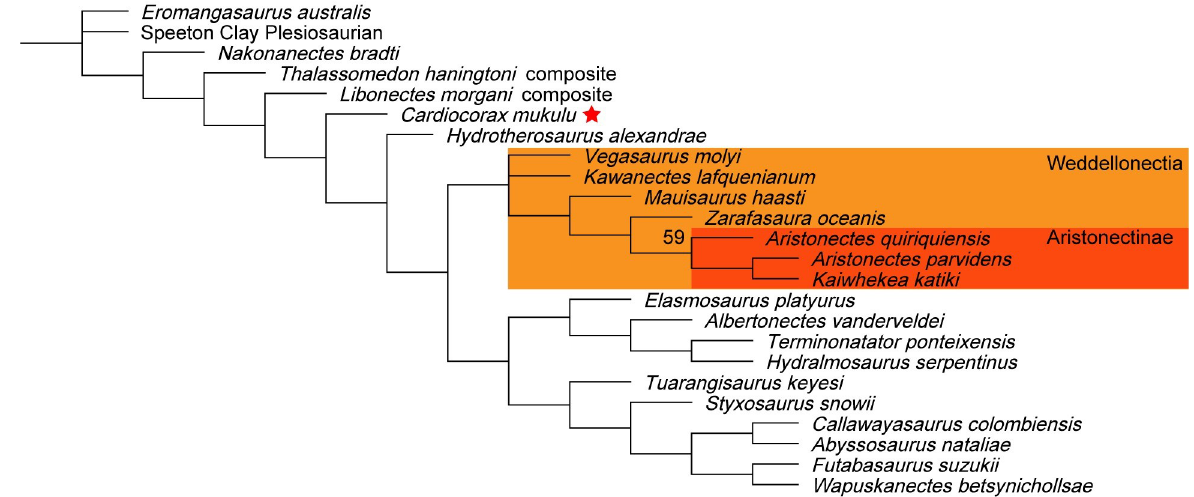
Fig 31. Implied weighting with Sachs et al. (2021) matrix (K = 3). Symmetric resampling values above 50 displayed above nodes.